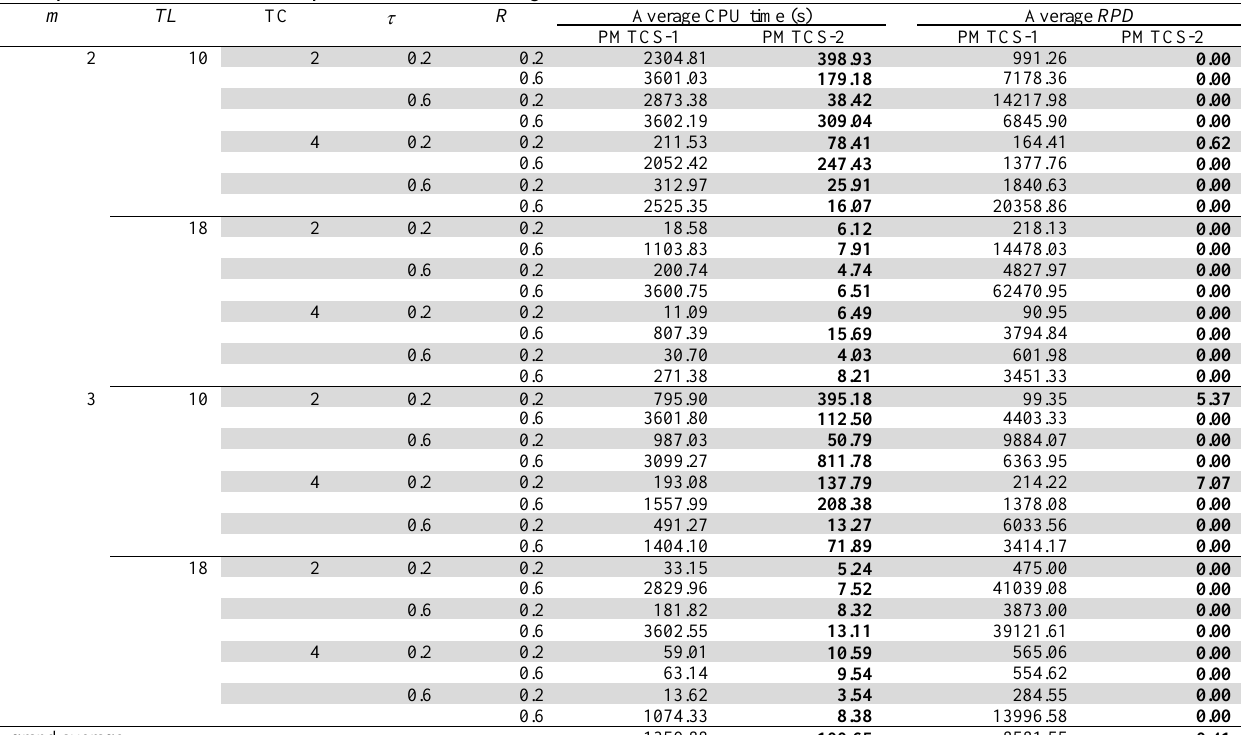
Computational results for problems with 15